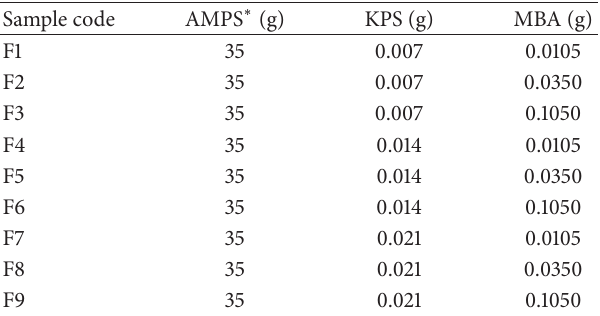
Table 1: Preparation of poly(2-acrylamido-2-methylpropane sul- fonic acid) (PAMPS)